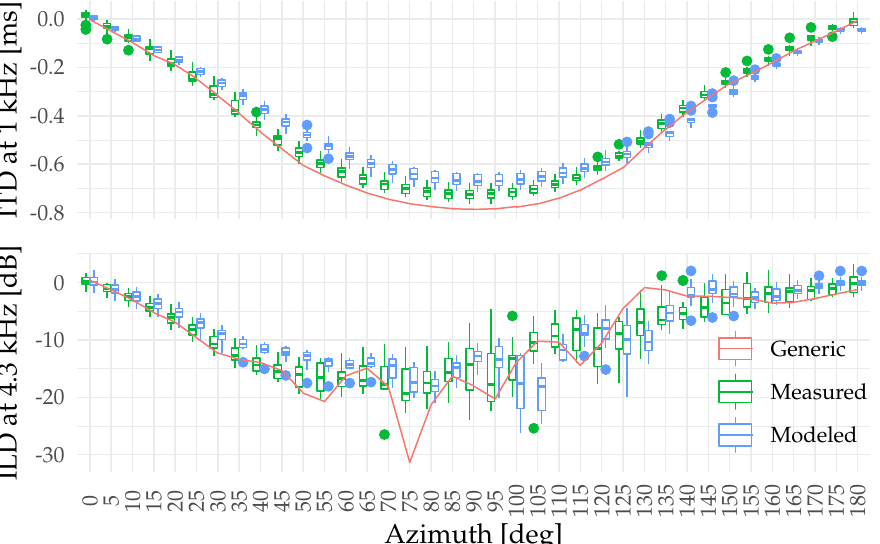
Figure 1. ITD in the ERB band centered at 1.0 kHz (bandwidth 133 Hz) and the ILD in the ERB band centered at 4.3 kHz (bandwidth 489 Hz) based on an auditory model by Dietz et al. [32]. The boxplots show the sample median and the first and third quartiles, any data within 1.5 times the interquartile range, and any outliers outside the range. Azimuth φ = 0 ◦ corresponds to the direction in front of the listener and positive angles are clockwise towards behind the